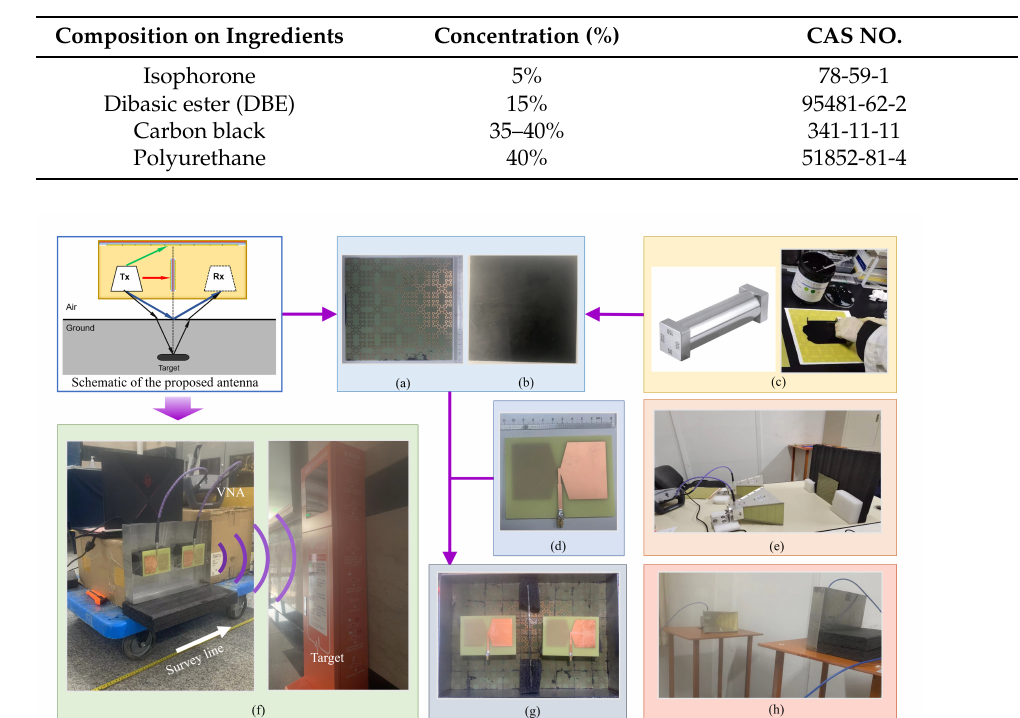
Figure 10. The photograph of the experiment equipment and the transceiver antenna. ( a ) The top view and ( b ) The back view of MMA. ( c ) The wet film coater (in left) and the resistive film process (in right). ( d ) The bow-tie antenna. ( e ) The absorptance measurement. ( f ) The setup of the reflection measurement (in left) and the metallic box (in right). ( g ) The proposed transceiver antenna with MMA. ( h ) The radiation parameter